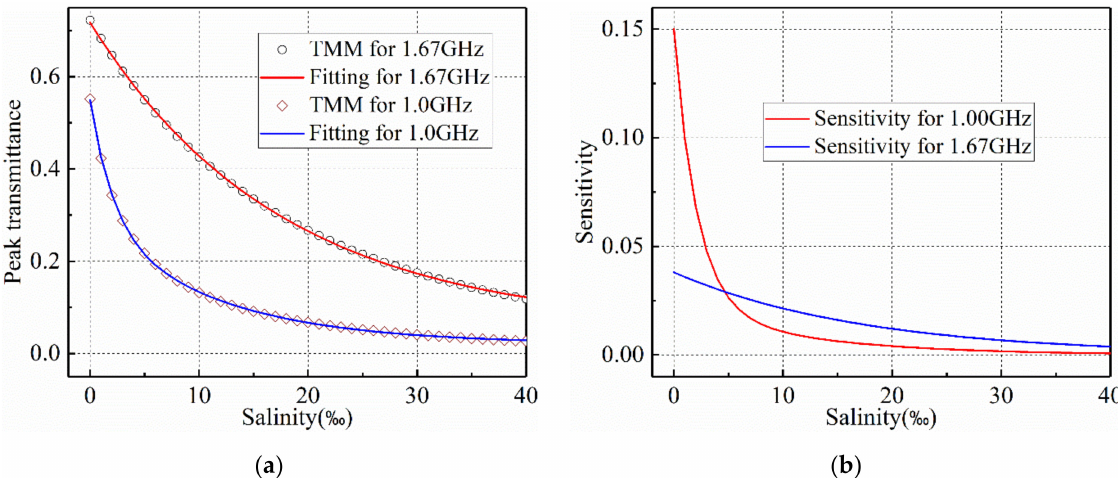
Figure 8. ( a ) Peak transmittance of the defective resonance and the first transmitting mode, and ( b ) the detecting sensitivity of the peak transmittance versus salinity for the 7-layer defective MPC